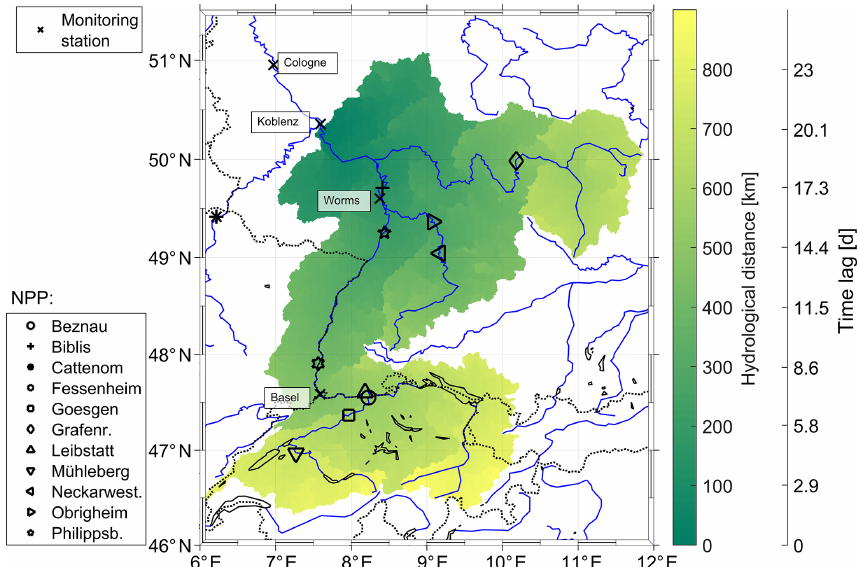
Figure 2. Catchment area of the Koblenz monitoring station as an example. The colors show the hydrological distance between the monitoring station and each grid point of the catchment area. The second y axis shows the time it takes in days, in our setup, to flow from a certain grid point to the monitoring station, based on the hydrological distance. The flow speed is 0.4ms − 1 and was defined to be constant in space and time. All monitoring stations are marked by a cross. The other markers show the location of the NPPs.